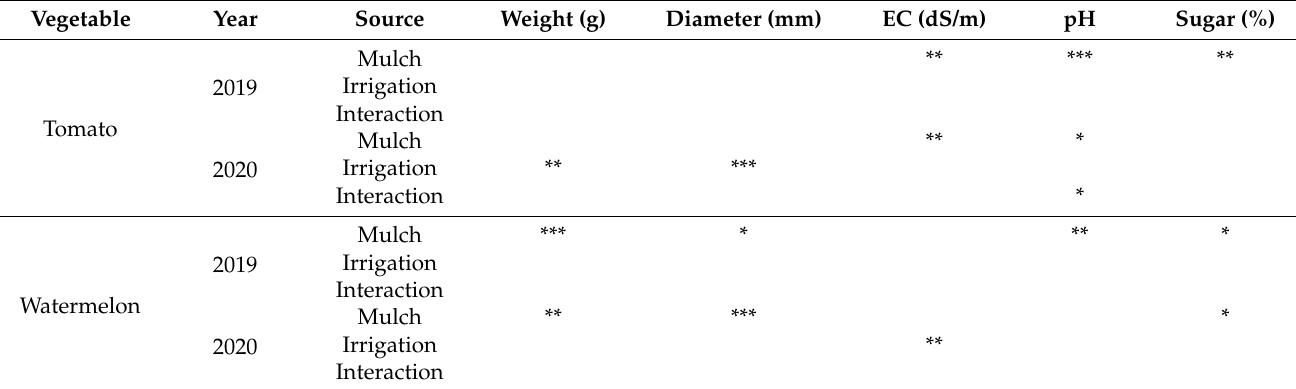
Table 9. Tomato and watermelon quality parameter analysis on mulch, irrigation, and the interaction of mulch and irrigation in 2019 and 2020 using analysis of variance, with * at p < 0.05, ** at p < 0.01, and *** at p < 0.001.